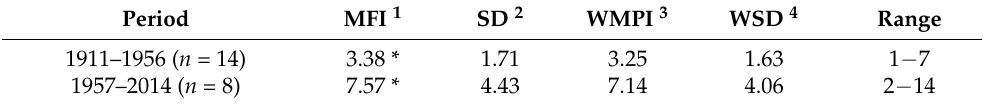
Table 2. Fire history statistics for pre- and post-management periods. Values are in years. Period MFI 1 SD 2 WMPI 3 WSD 4